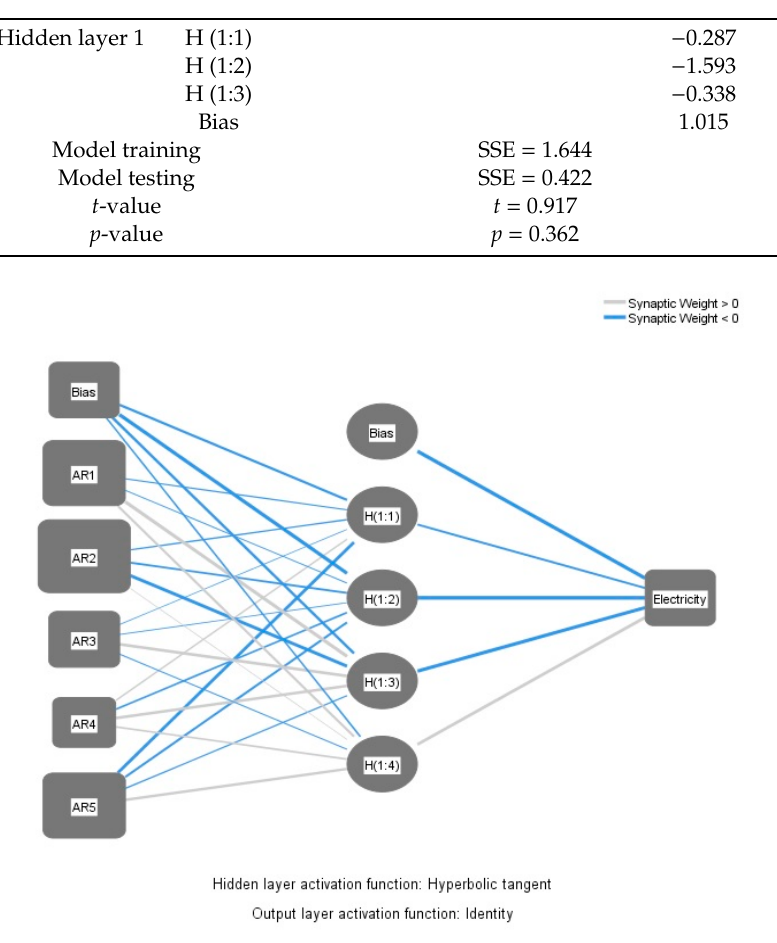
Figure 7. ANN model for household electricity consumption.